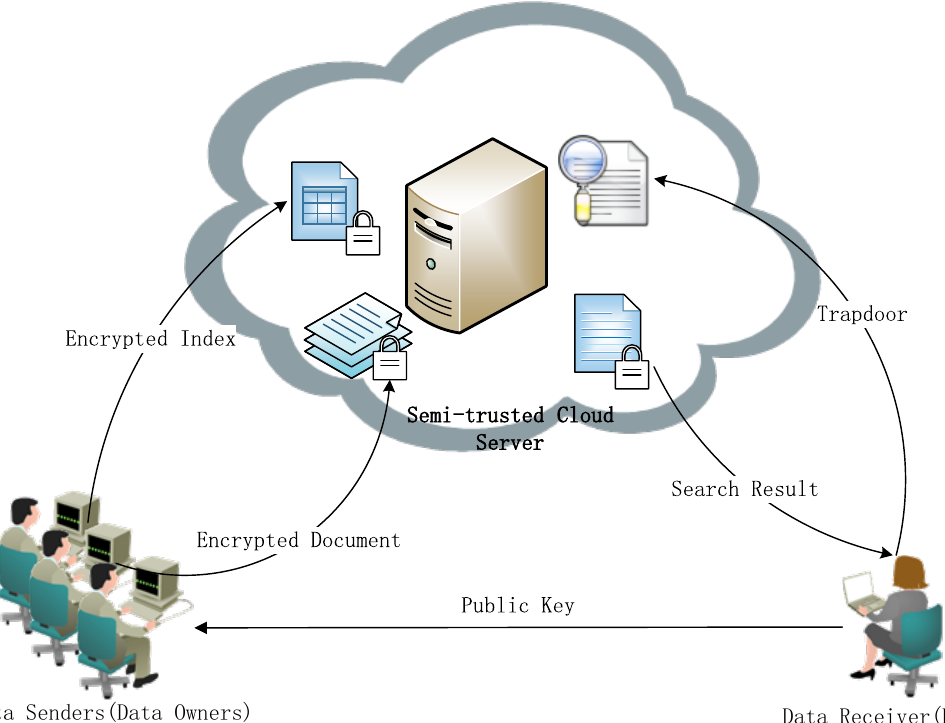
Figure 1. Architecture of the search over encrypted cloud